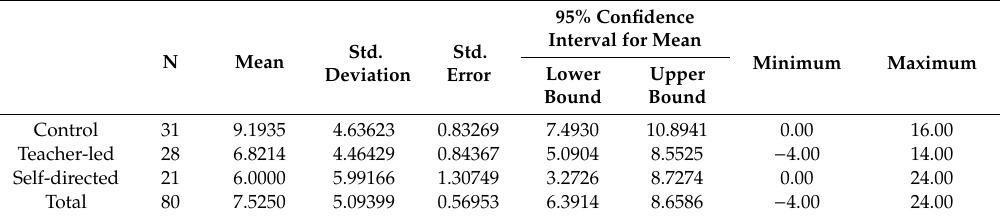
Table 6. Descriptive statistics for listening performance